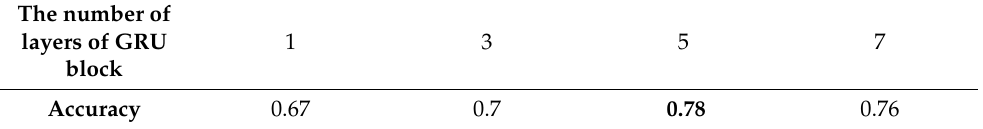
Table 5. The classification accuracy of the psychological stress of the GRU block of the proposed method under different numbers of neural network layers. The number in bold represents the best